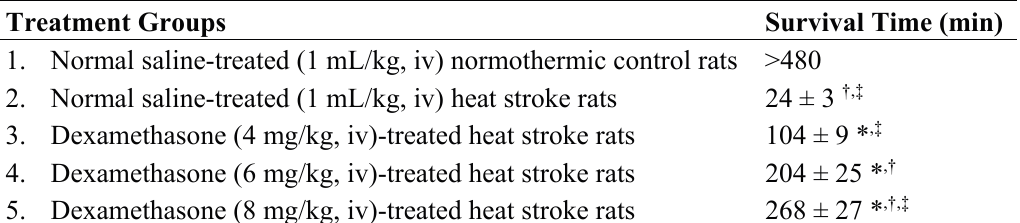
Table 1. Effects of heat exposure (HE; ambient temperature of Ta = 43 °C for 70 min) on survival time values in different groups of